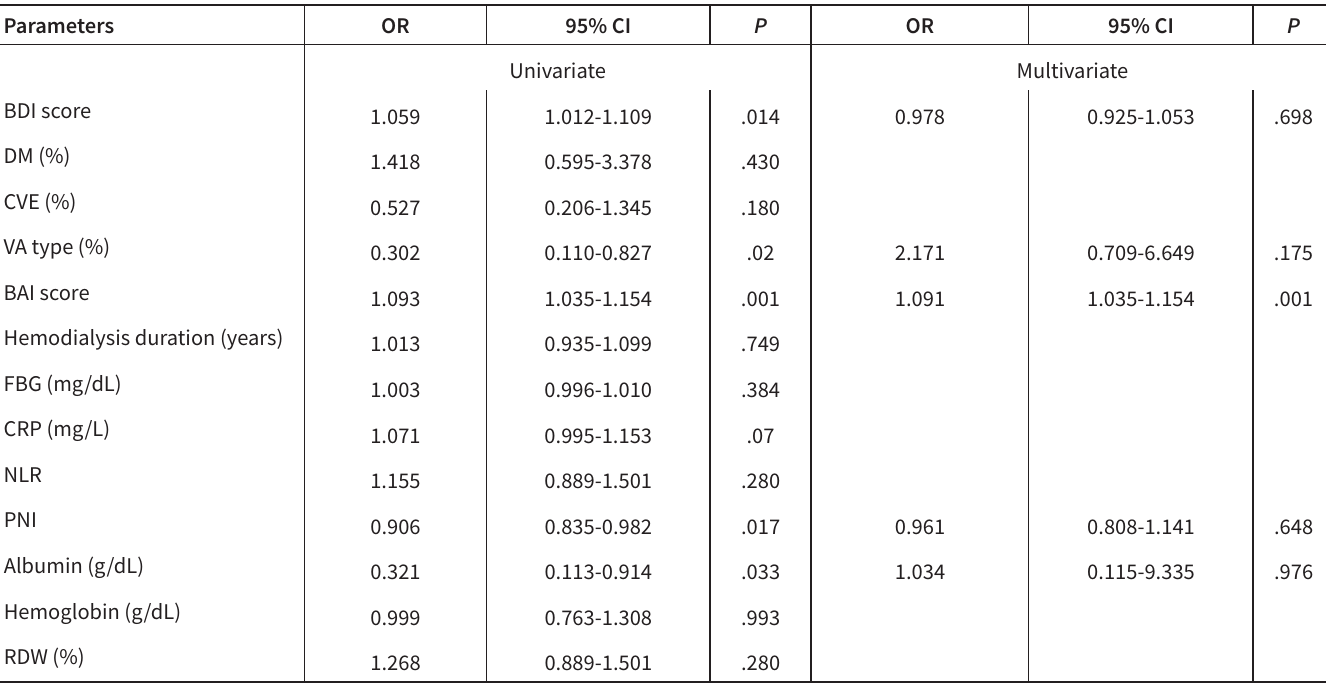
Table 2. Regression Analysis of Factors Affecting Sleep Quality in Hemodialysis Patients Parameters